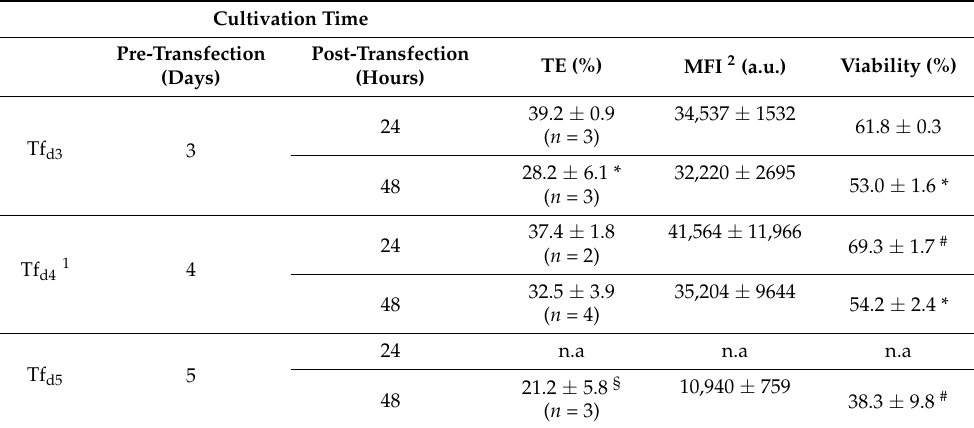
Table 3. Transfection outcomes as a function of the pre- and post-transfection cultivation